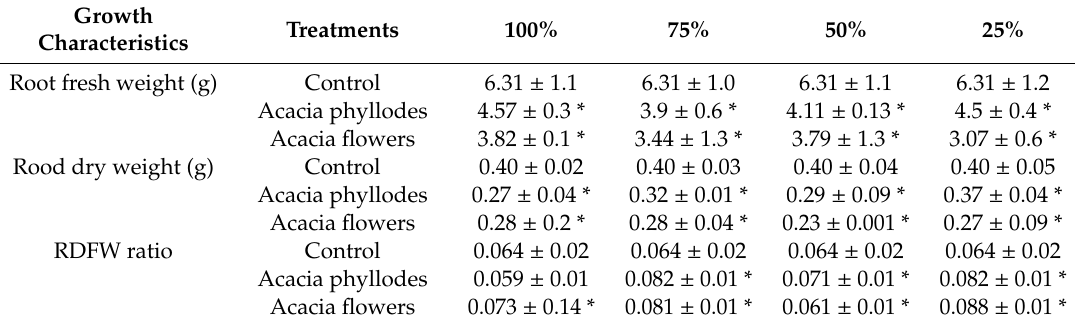
Table 2. E ff ect of aqueous extract of aerial foliage of Acacia melanoxylon R. Br. on on root fresh weight (g) and root dry weight (g) of one month old general biotest species, Lactuca sativa L. RDFW ratio (Root dry weight fresh weight